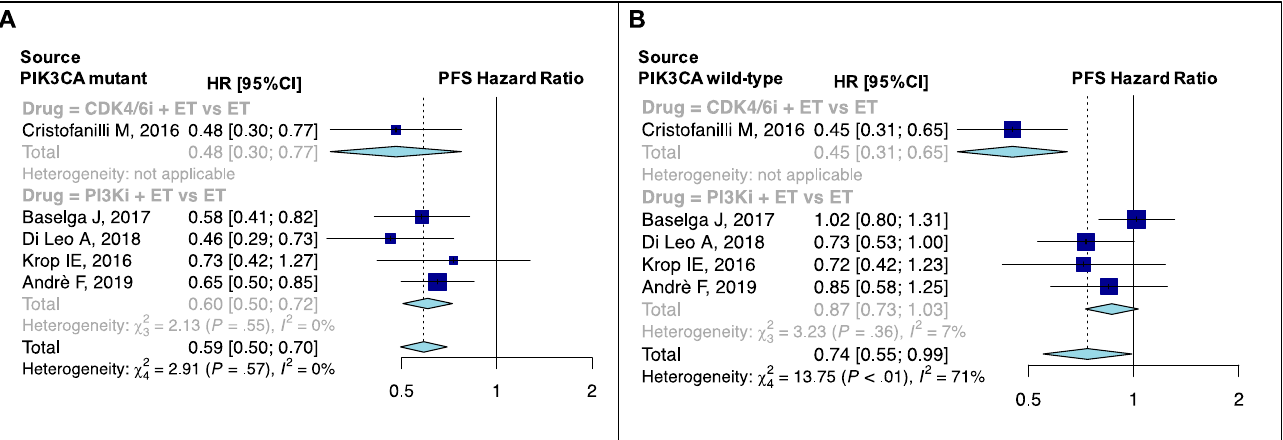
Figure 5. PFS pooled results according to PIK3CA mutational status: PFS pooled results for PIK3CA-mutant ( A ) and non-mutant ( B ) patients, overall and according to drug classes. PFS, progression-free survival; ET, endocrine therapy; HR, hazard ratio; 95% CI, 95% confidence interval. PI3Ki, phosphatidylinositol 3-kinases inhibitors; CDK4/6i, Cyclin-dependent kinases 4/6 inhibitors. Table 1. PFS and OS pooled results according to each patients’